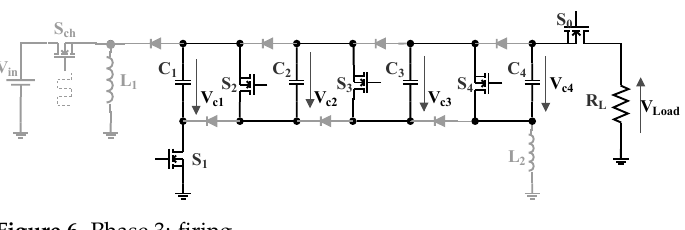
Figure 6. Phase 3: